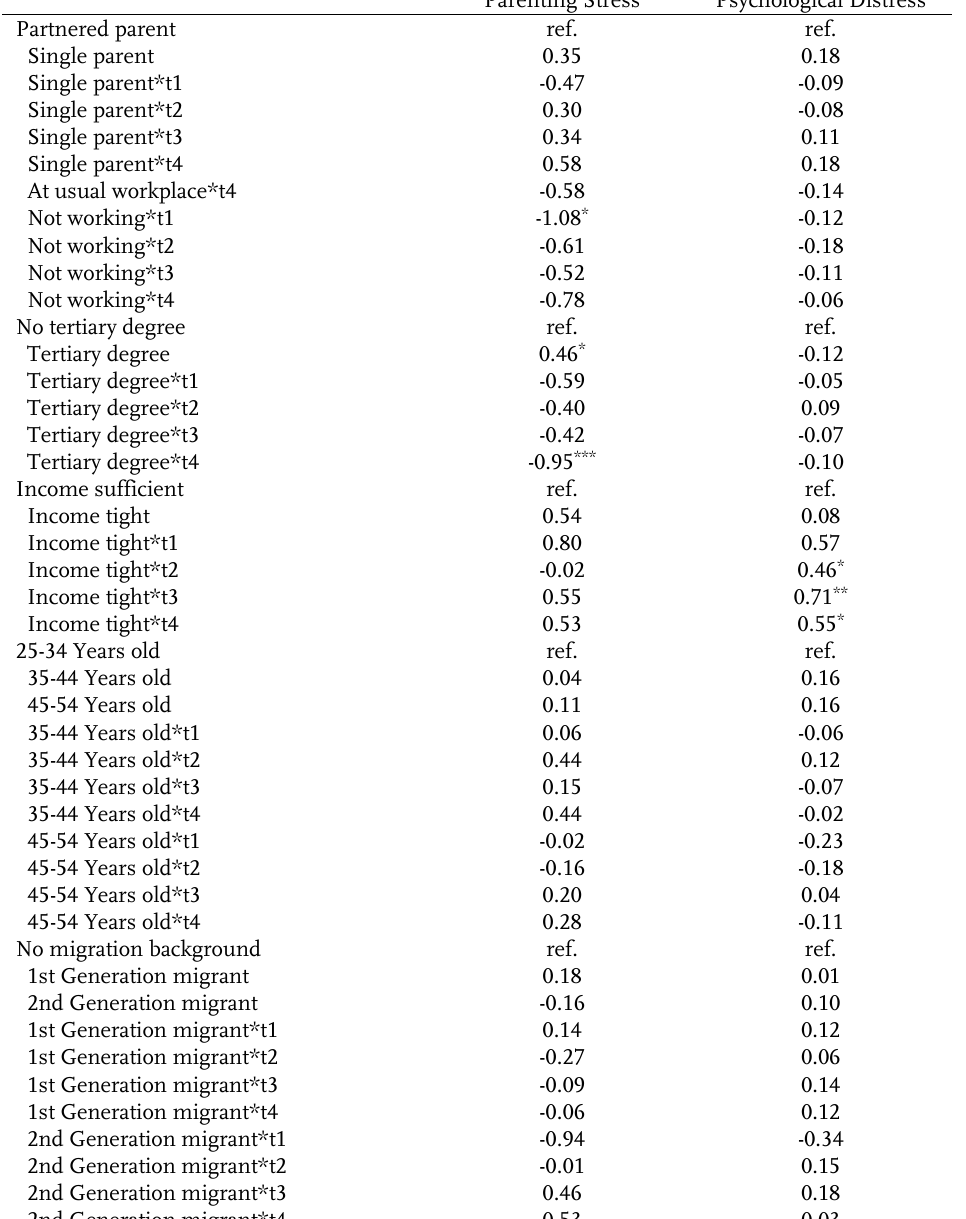
Table A.2: OLS Regressions on Parenting Stress and Psychological Distress (continued) Parenting Stress Psychological Distress